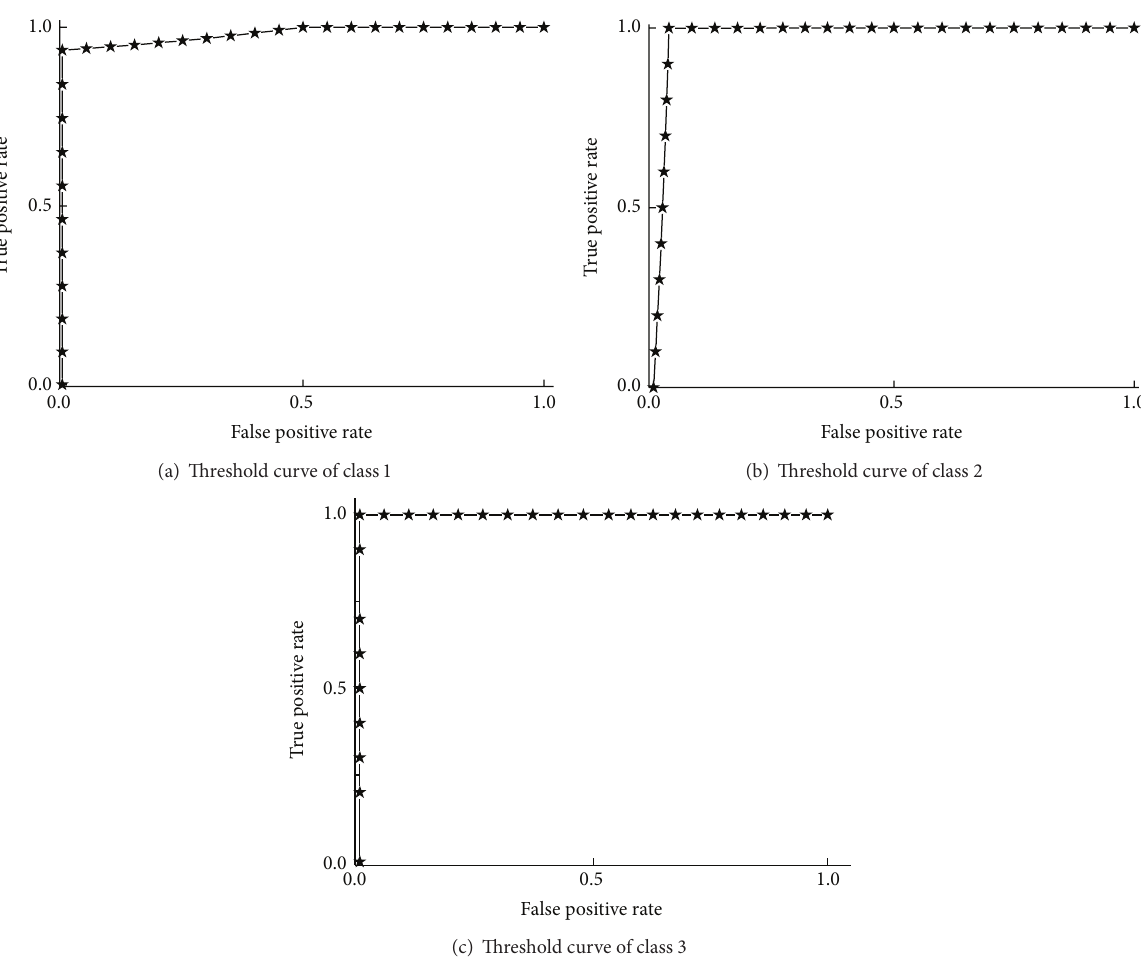
Figure 5: Threshold curve of